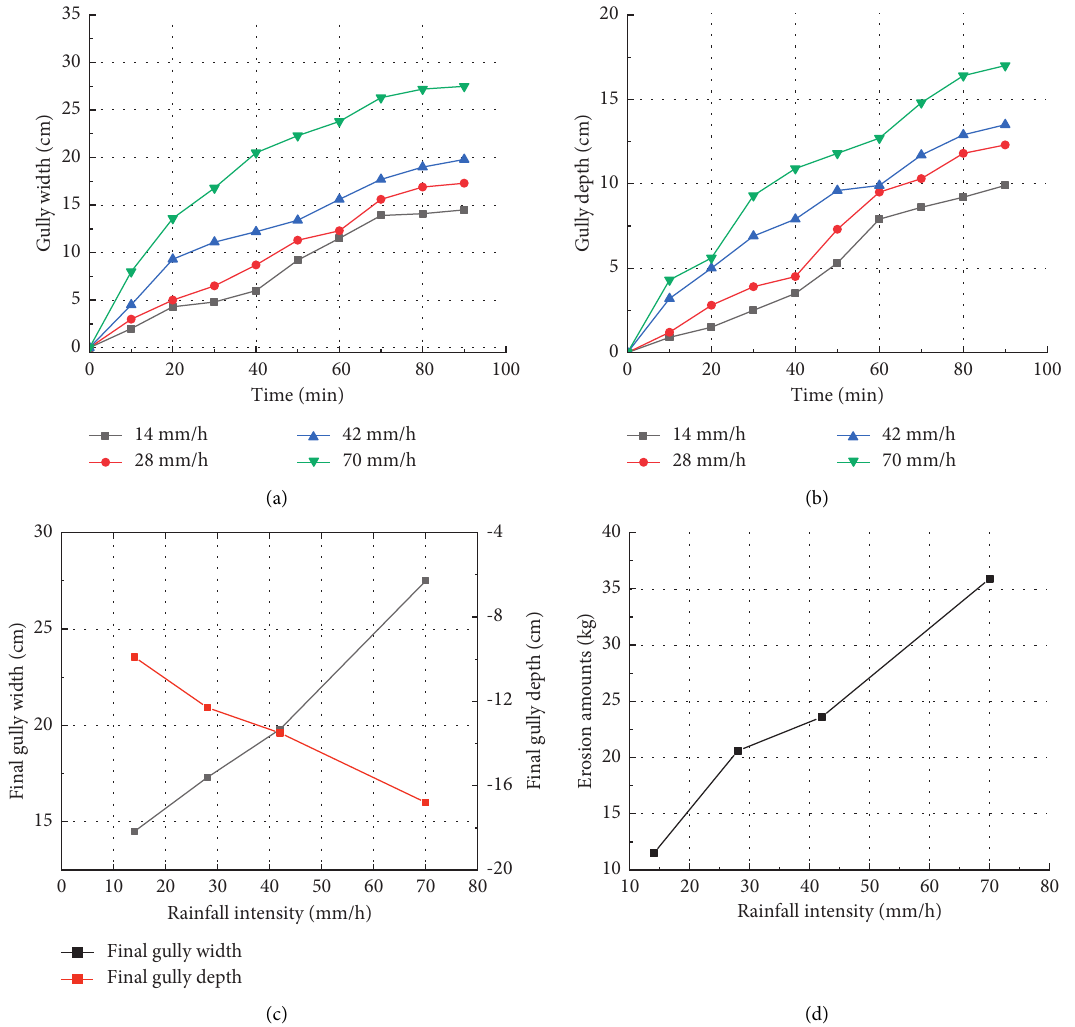
Figure 6: Effect of embankment erosion under different rainfall intensities: (a) gully width changes with time; (b) gully depth changes with time; (c) final gully width and depth; (d) final erosion amount.